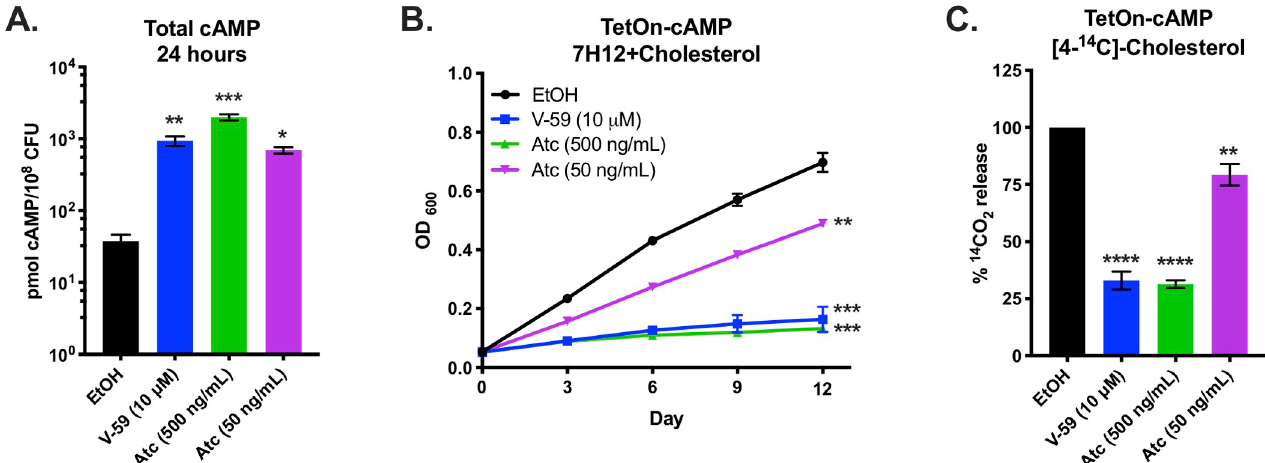
Fig 5. Inducing cAMP synthesis independent of V-59 and Rv1625c is sufficient to block cholesterol utilization. ( A ) Total cAMP induced in TetOn-cAMP Mtb. Cultures were treated with V-59 (10 μΜ ), Atc (500 ng/mL or 50 ng/mL), or EtOH and samples were collected after 24 hours. Data are normalized as total cAMP per 10 8 Mtb and are from two experiments with two technical replicates each. ( B ) Impact of inducing TetOn-cAMP on the growth of Mtb in cholesterol media. Cultures were treated with V-59 (10 μ M) or Atc for the duration of the experiment. Data are from two experiments with three technical replicates. ( C ) Catabolic release of 14 CO 2 from [4- 14 C]-cholesterol in the TetOn-cAMP strain treated with V-59, Atc, or EtOH. Data are from two experiments with three technical replicates, normalized to OD and quantified relative to EtOH EtOH is the vehicle control throughout. All data are means ± SD ( � P < 0.05, �� P < 0.01, ��� P < 0.001, ���� P < 0.0001, One-way ANOVA with Dunnet’s multiple comparisons test).